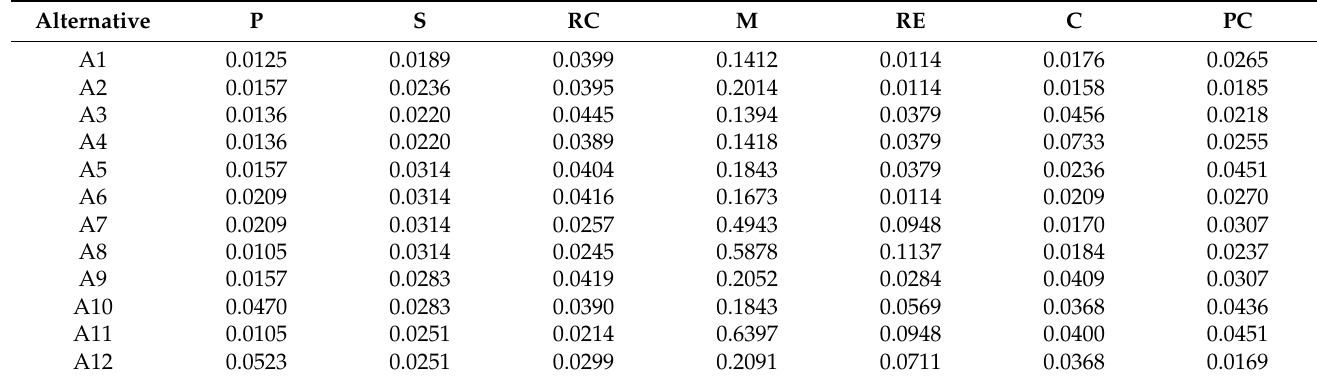
Table 4. Normalized decision matrix for CODAS.